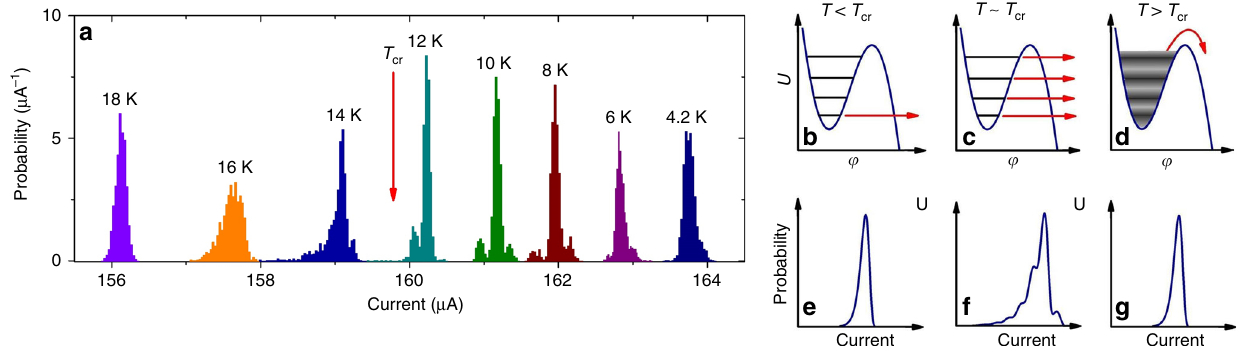
Fig. 2 Switching-current measurements for the nanowire under equilibrium conditions. a SCDs for a 55-nm-wide YBCO nanowire. Source data are provided as a Source Data fi le. b – g Washboard potential with quantum states b – d and corresponding SCDs e – f measured with a non-adiabatic sweep rate at temperatures below, close to, and above the crossover temperature between the MQT and TA